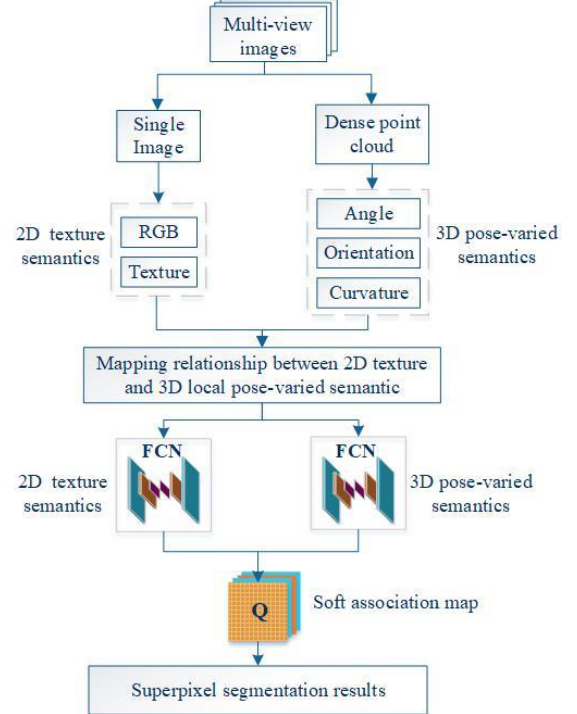
Figure 1 . Flowchart of Pose-FCN.